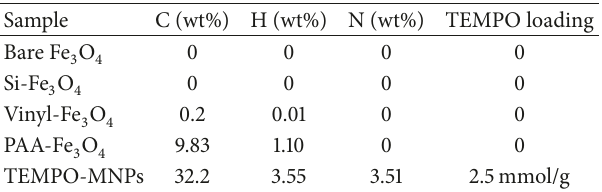
Scheme 2: Schematic illustration for the inverse emulsion polymer- ization.